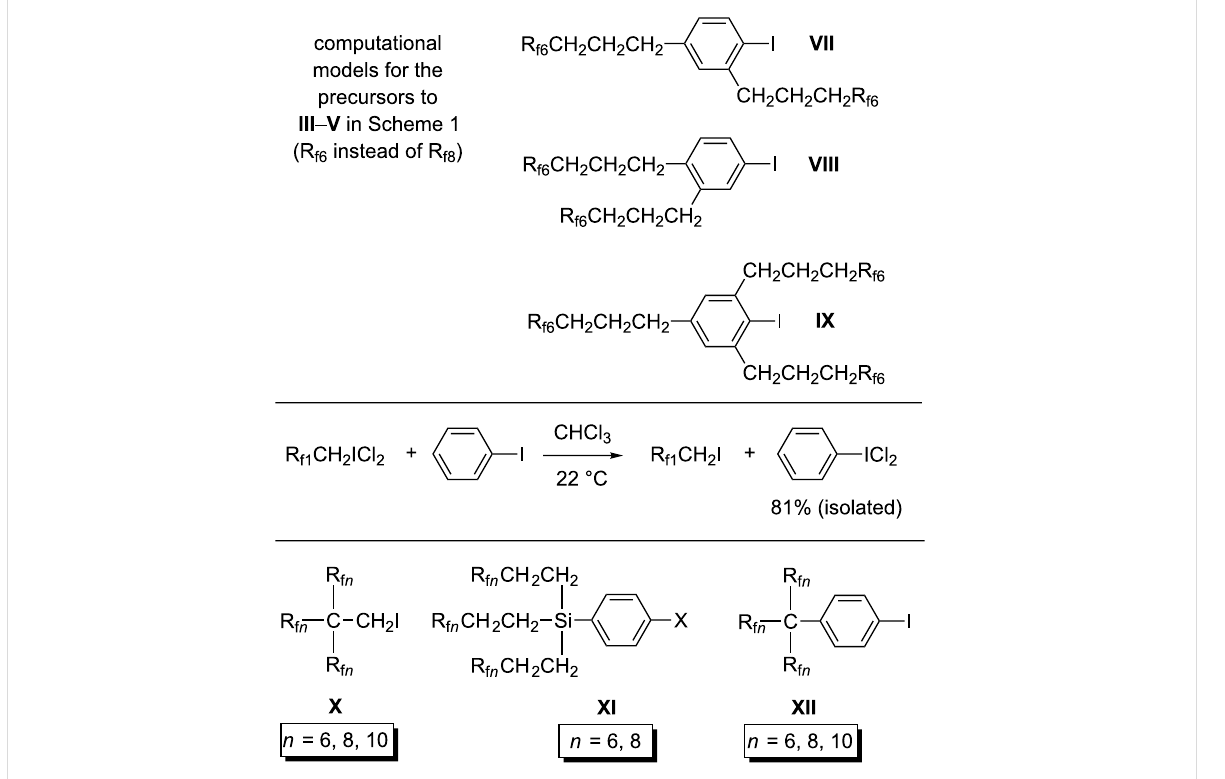
Scheme 7: Other relevant fluorous compounds and reactions.